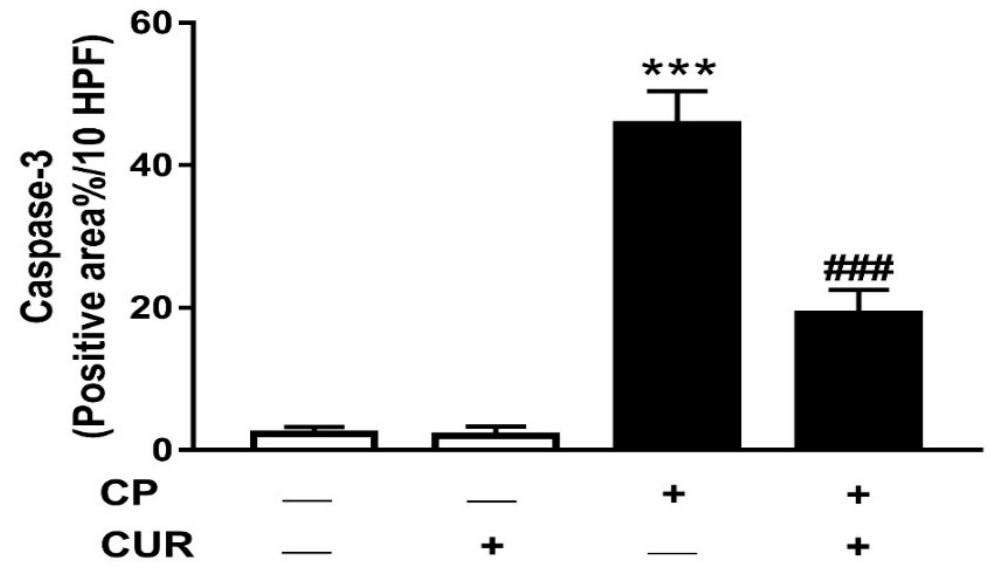
Figure 4. Effect of CUR on caspase-3 in lung of control and CP-induced rats. Values are represented as mean ± SEM, n = 8, *** p < 0.001 versus control and ### p < 0.001 versus CP.